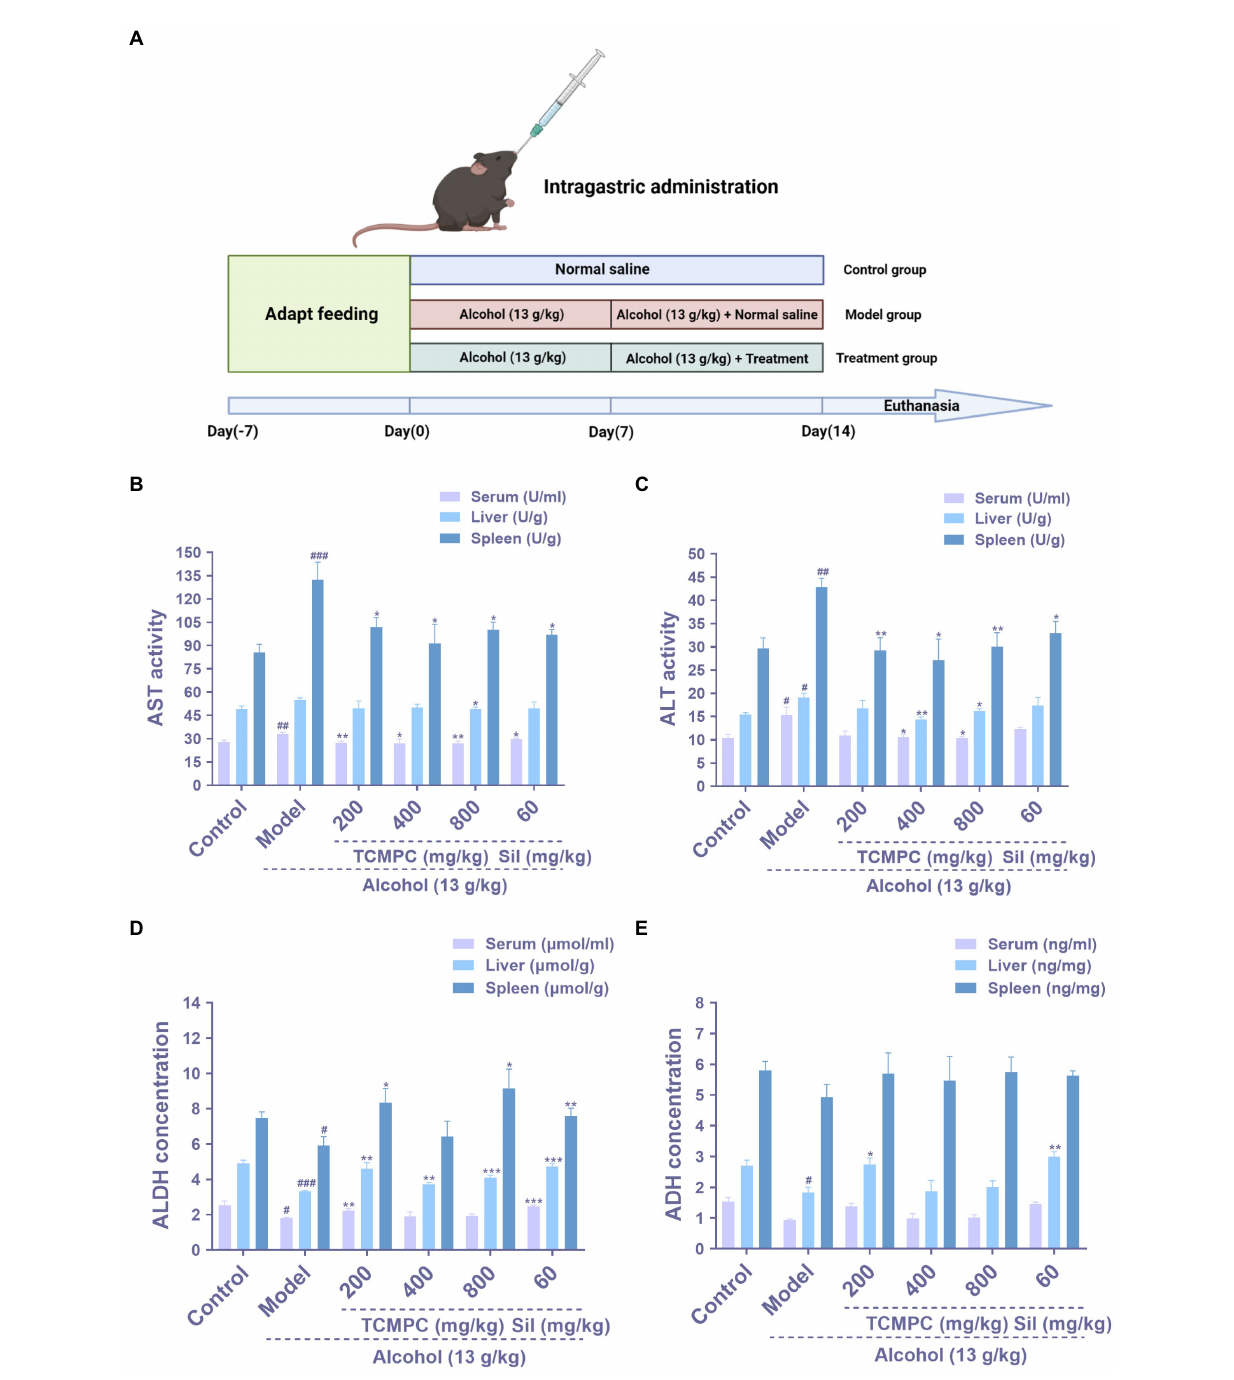
FIGURE 1 The hepatoprotective effects by TCMPC in mice with alcohol-induced ALI. Schematic diagram of the administration of alcohol-induced ALI mice in the control group, model group, and treatment groups after 1 week of adaptive feeding (A) , The effects of TCMPC on AST levels of serum, liver, and spleen, respectively, in alcohol-treated mice (B) , The effects of TCMPC on ALT levels of serum, liver, and spleen, respectively (C) , The effects of TCMPC on ALDH levels of serum, liver, and spleen, respectively (D) , and The effects of TCMPC on ADH levels of serum, liver, and spleen, respectively (E) . Data are expressed as mean ± SD, n = 10. # p < 0.05, ## p < 0.01, and ### p < 0.001, versus control group. * p < 0.05, ** p < 0.01, and *** p < 0.001, versus model group. AST, aspartate aminotransferase; ALT, alanine aminotransferase; ALDH, aldehyde dehydrogenase; ADH, antidiuretic